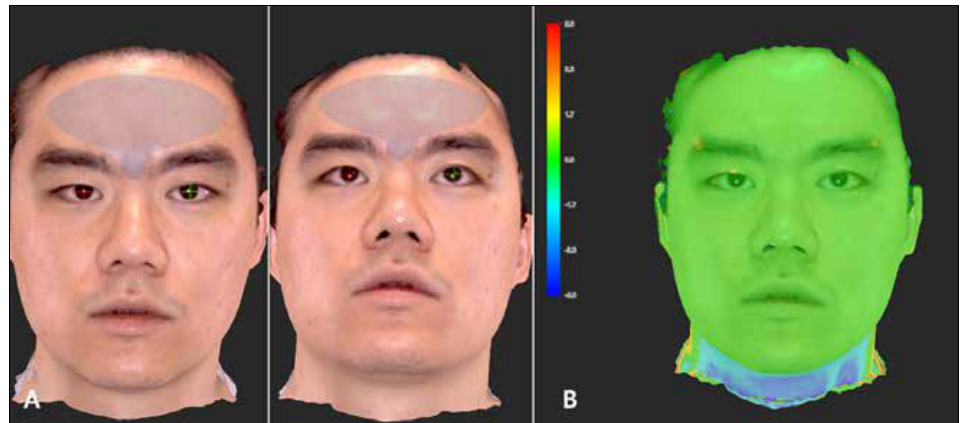
Figure 5. Superimposition of each different head posture with natural head position 1 (NHP1) was executed with reference to a wide forehead using a chamfer mapping algorithm, (A) Superimposed colour map image, (B) Green indicates a deviation within 1 mm. Increase in the blue colour gradient indicates a greater inward deviation. Increase in the red colour gradient indicates a greater outward